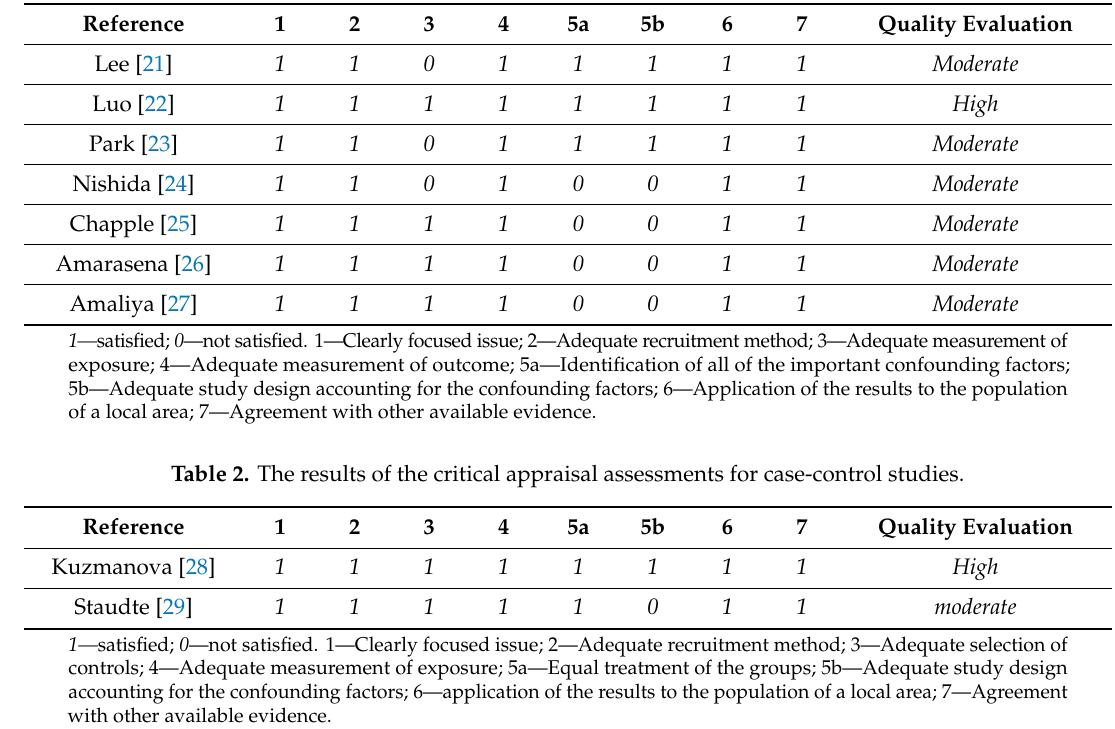
Table 1. The results of the critical appraisal assessments for cross-sectional studies.